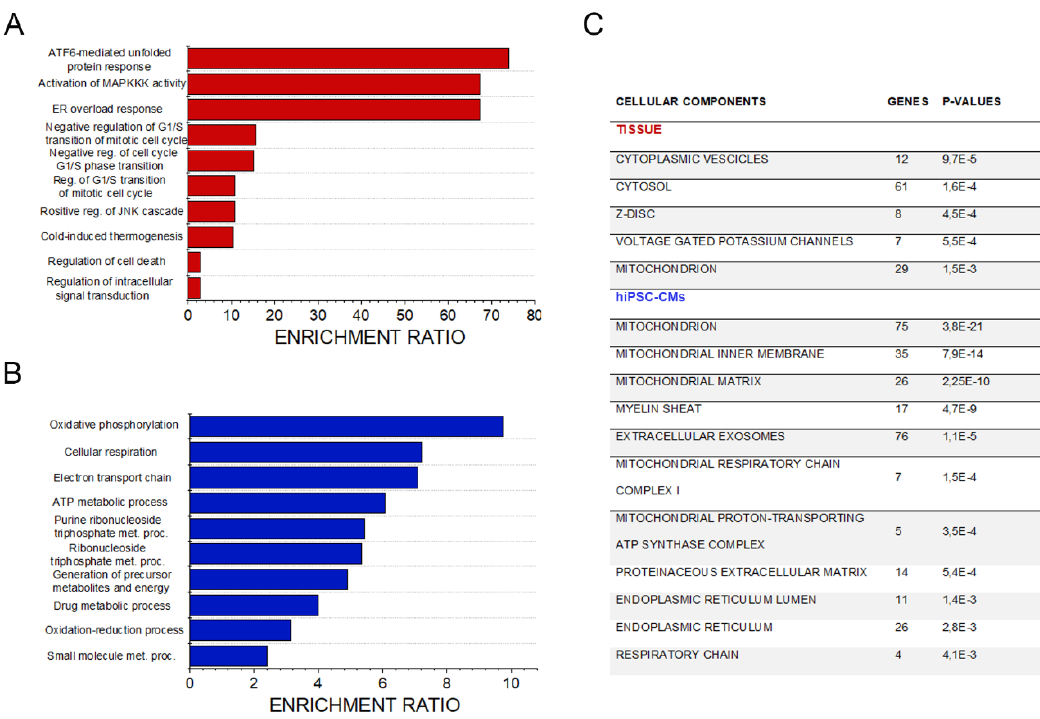
Figure 2. Pathway analysis. Overexpression enrichment analysis of cardiac tissue transcriptome ( A ) and hiPSC-CM transcriptome ( B ). Summary of the cellular components significantly regulated in Danon patients’ derived hiPSC-CMs (FDR 0.01) compared to controls and heart biopsies (FDR 0.05) obtained with the David bioinformatics tool ( C ).